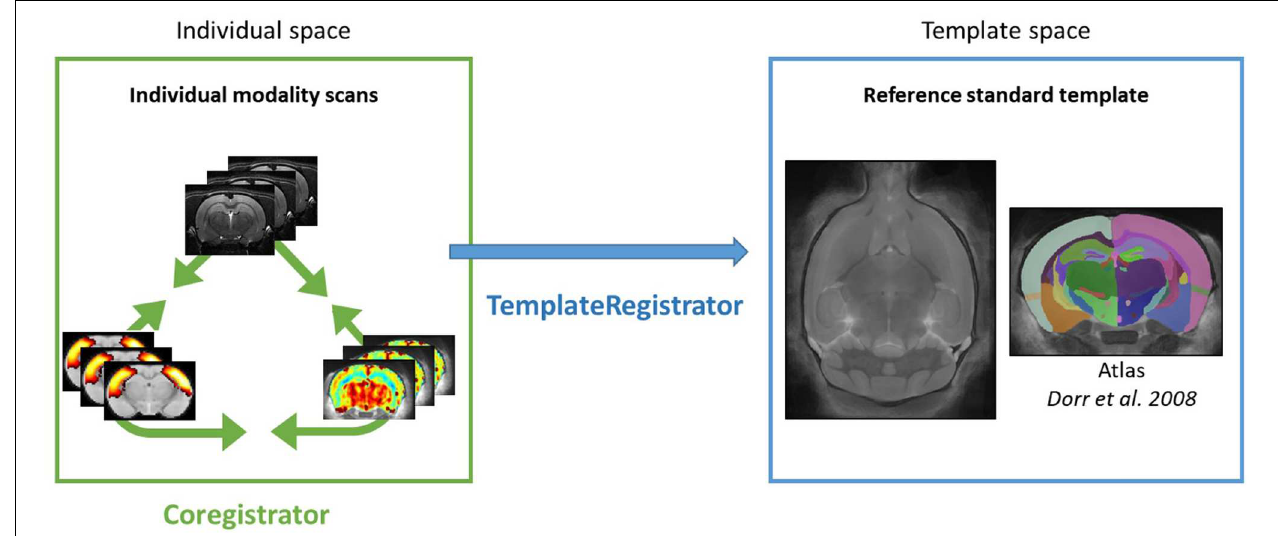
FIGURE 2 | Sammba-MRI pipelines. Color box represents spaces in which individual images are registered. Registration between individual modalities is performed by Coregistrator class (green arrow). Registration of individual modality images to a reference standard template space is performed by TemplateRegistrator class (blue